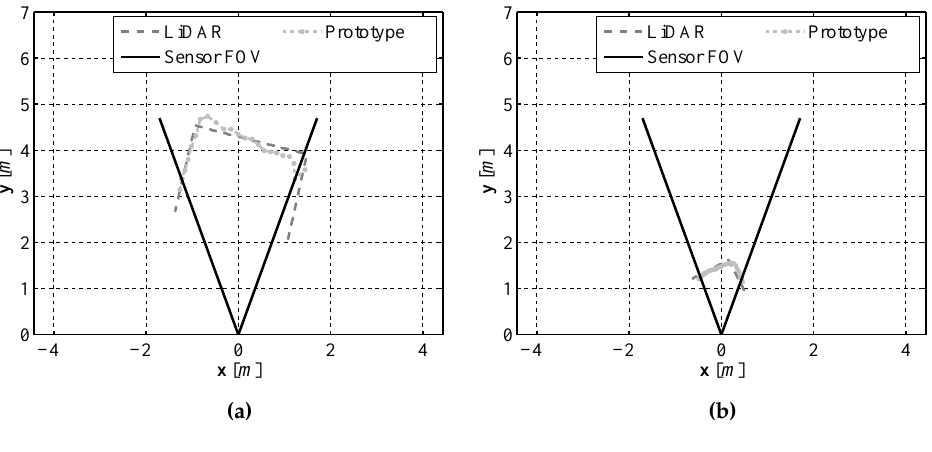
Figure 13. Comparison of a corner as viewed by the prototype sensor and LiDAR from 4.5 m ( a ) and 1.5 m ( b